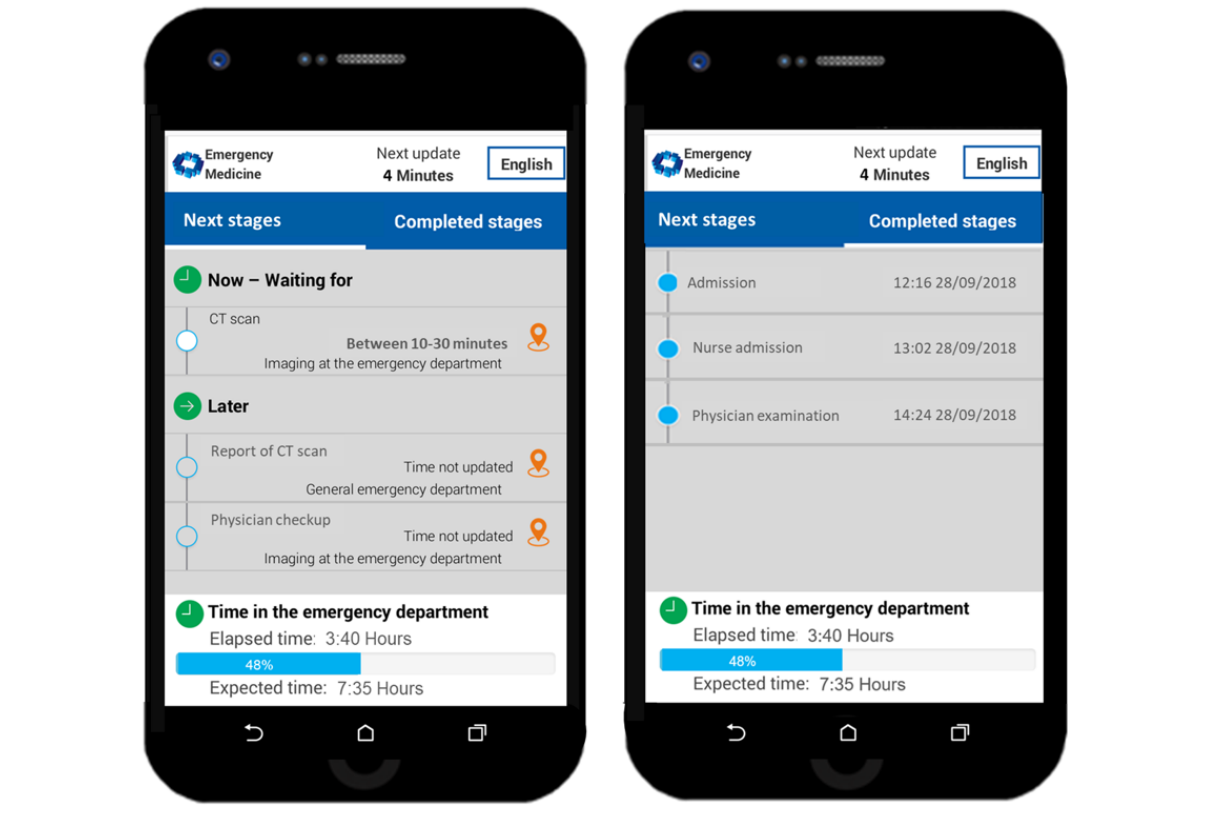
Figure 1. Screenshots of myED , available to an actual patient on September 28, 2018, 15:56.